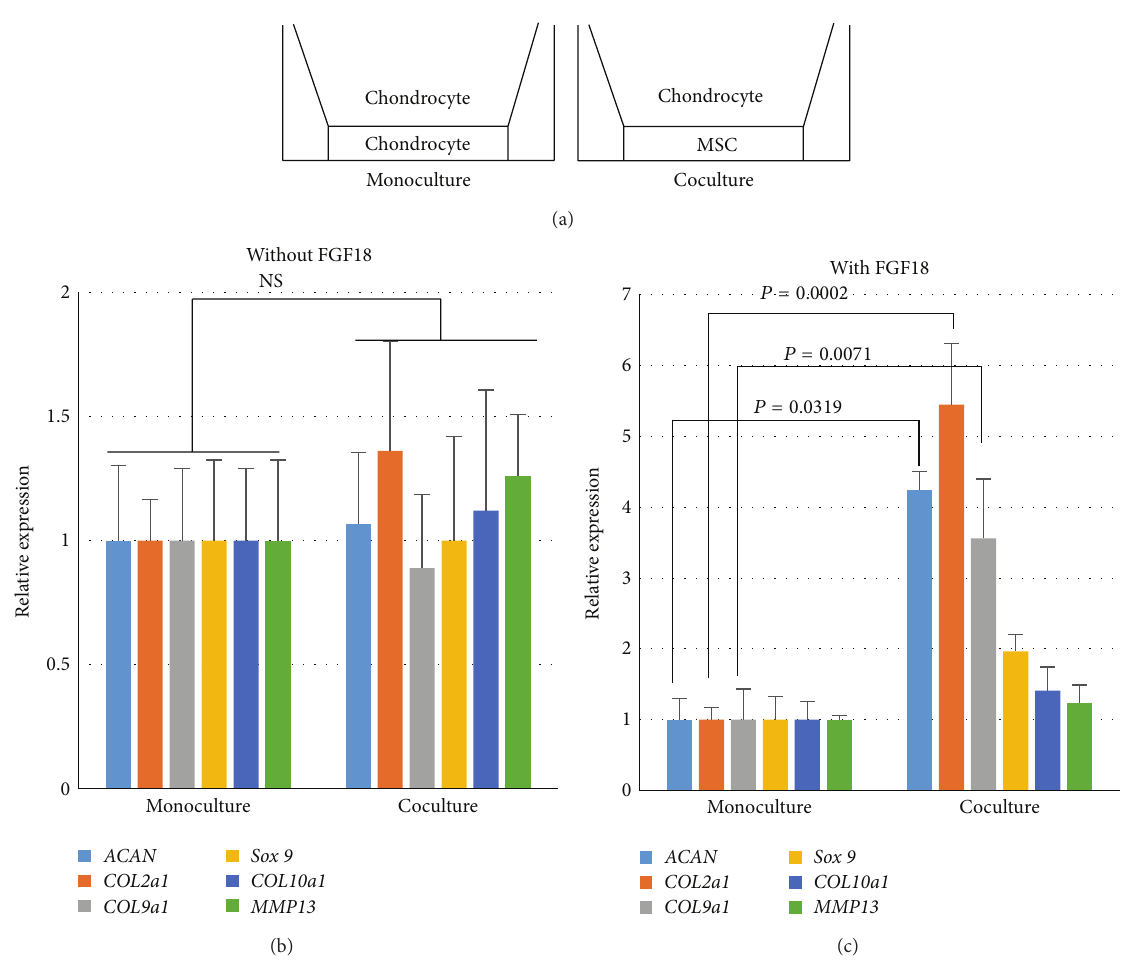
Figure 2: Expression of chondrogenic genes was measured by qPCR in OA chondrocytes cultured in transwells. (a) Diagram shows how monoculture or coculture is performed in transwell systems. (b) Expression of chondrogenic genes in chondrocytes cultured in transwells in medium without FGF18. Beta-actin was used for normalization. Monoculture was chosen as reference. Number in coculture represents the relative expression level of corresponding gene comparing to monoculture. Three donor pairs were analyzed. NS: nonsignificance. (c) Expression of chondrogenic genes in chondrocytes cultured in transwells in medium containing FGF18 (10ng/mL). Beta-actin was used for normalization. Monoculture was chosen as reference. Number in coculture represents the relative expression level of corresponding gene comparing to monoculture. Three donor pairs were analyzed. 𝑃 values are calculated with Student’s 𝑡